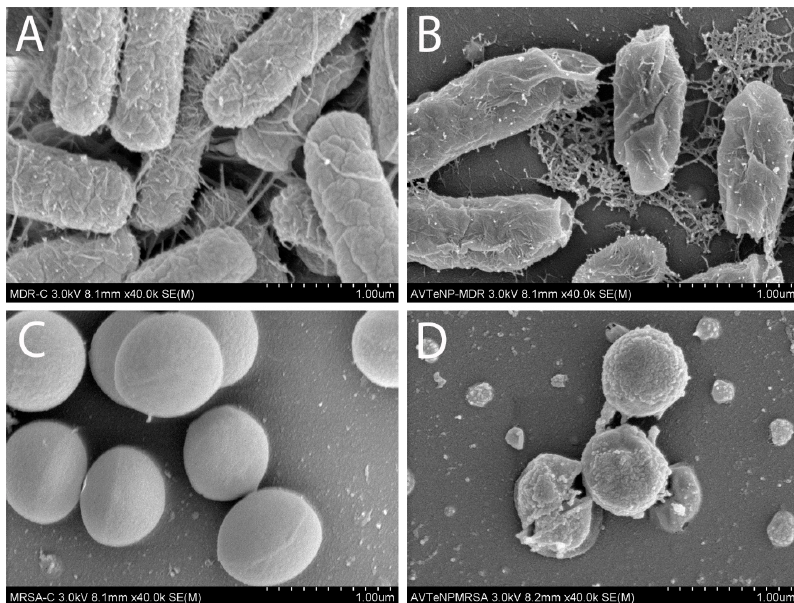
Figure A12. Representative SEM micrographs of multidrug-resistant (MDR) E. coli and methicillin- resistant Staphylococcus aureus (MRSA) ( A , C , respectively) without and with AV-TeNP treatment ( B , D , respectively).